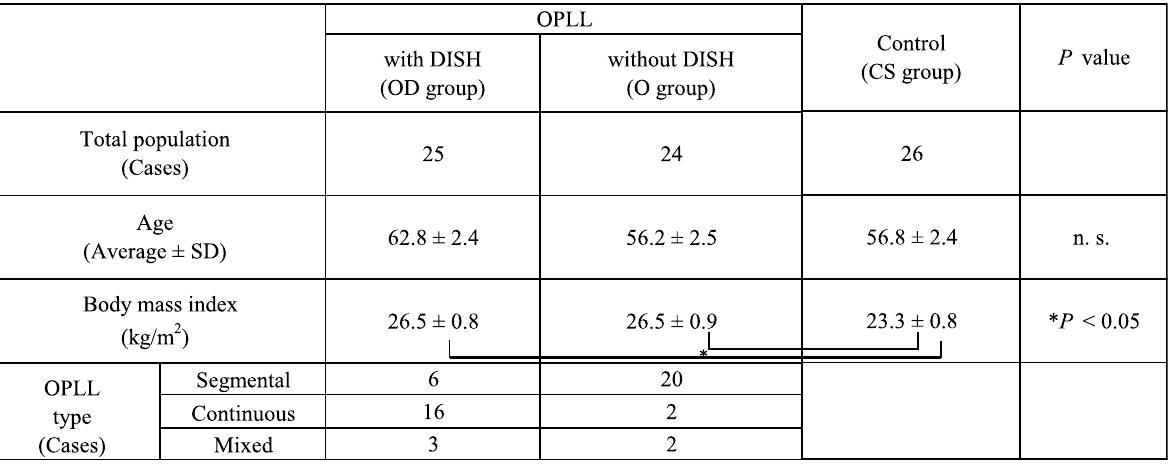
Table 1. The number of patients, mean age and body mass index (mean ± standard deviation), and ossi fi cation of the posterior longitudinal ligament classi fi cation type for each